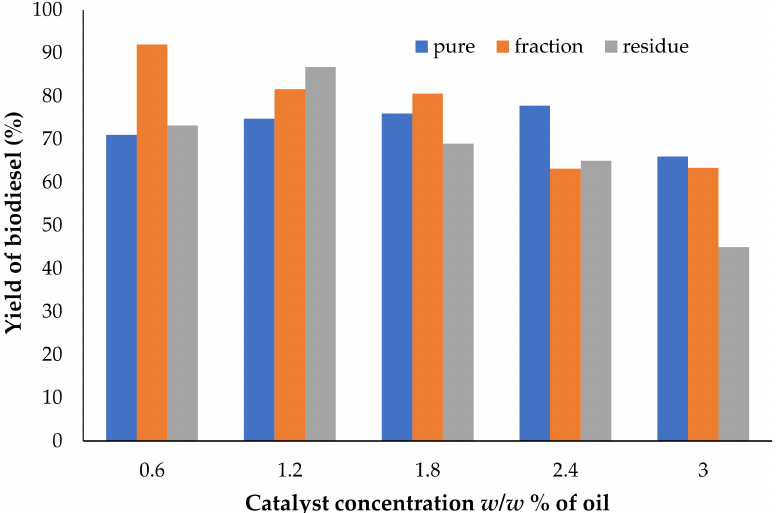
Figure 4. Effect of catalyst concentration on the yield of biodiesel produced from the non-treated pure, fraction, residual oil.